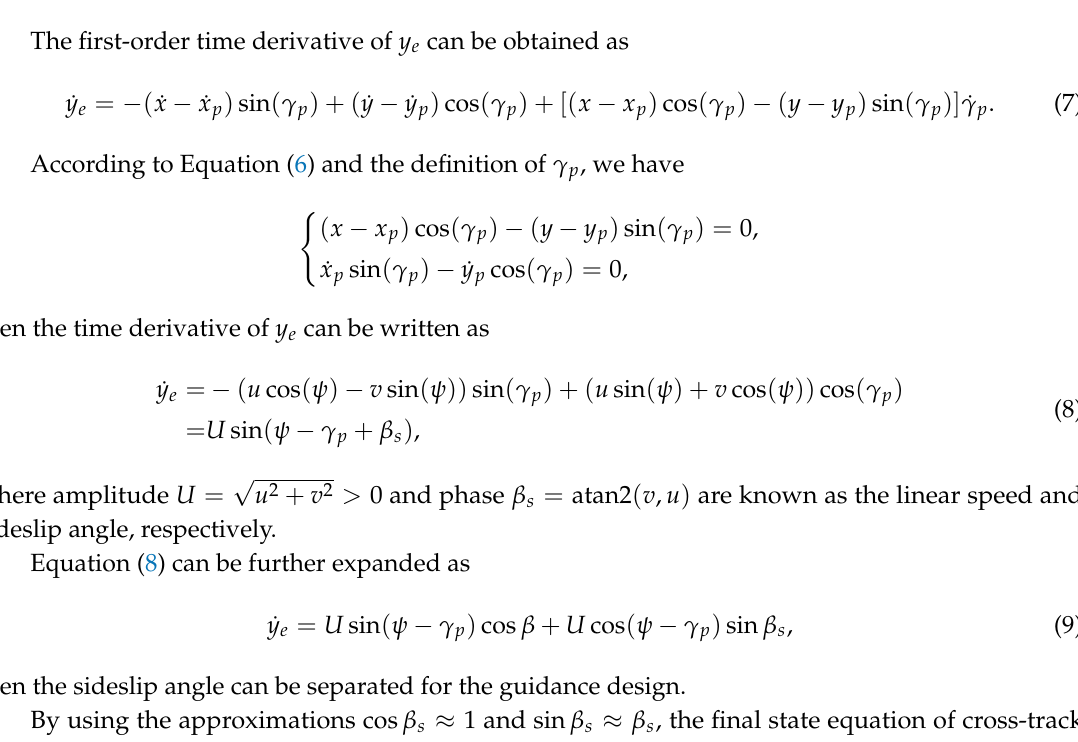
Figure 1. LOS guidance geometry for curved